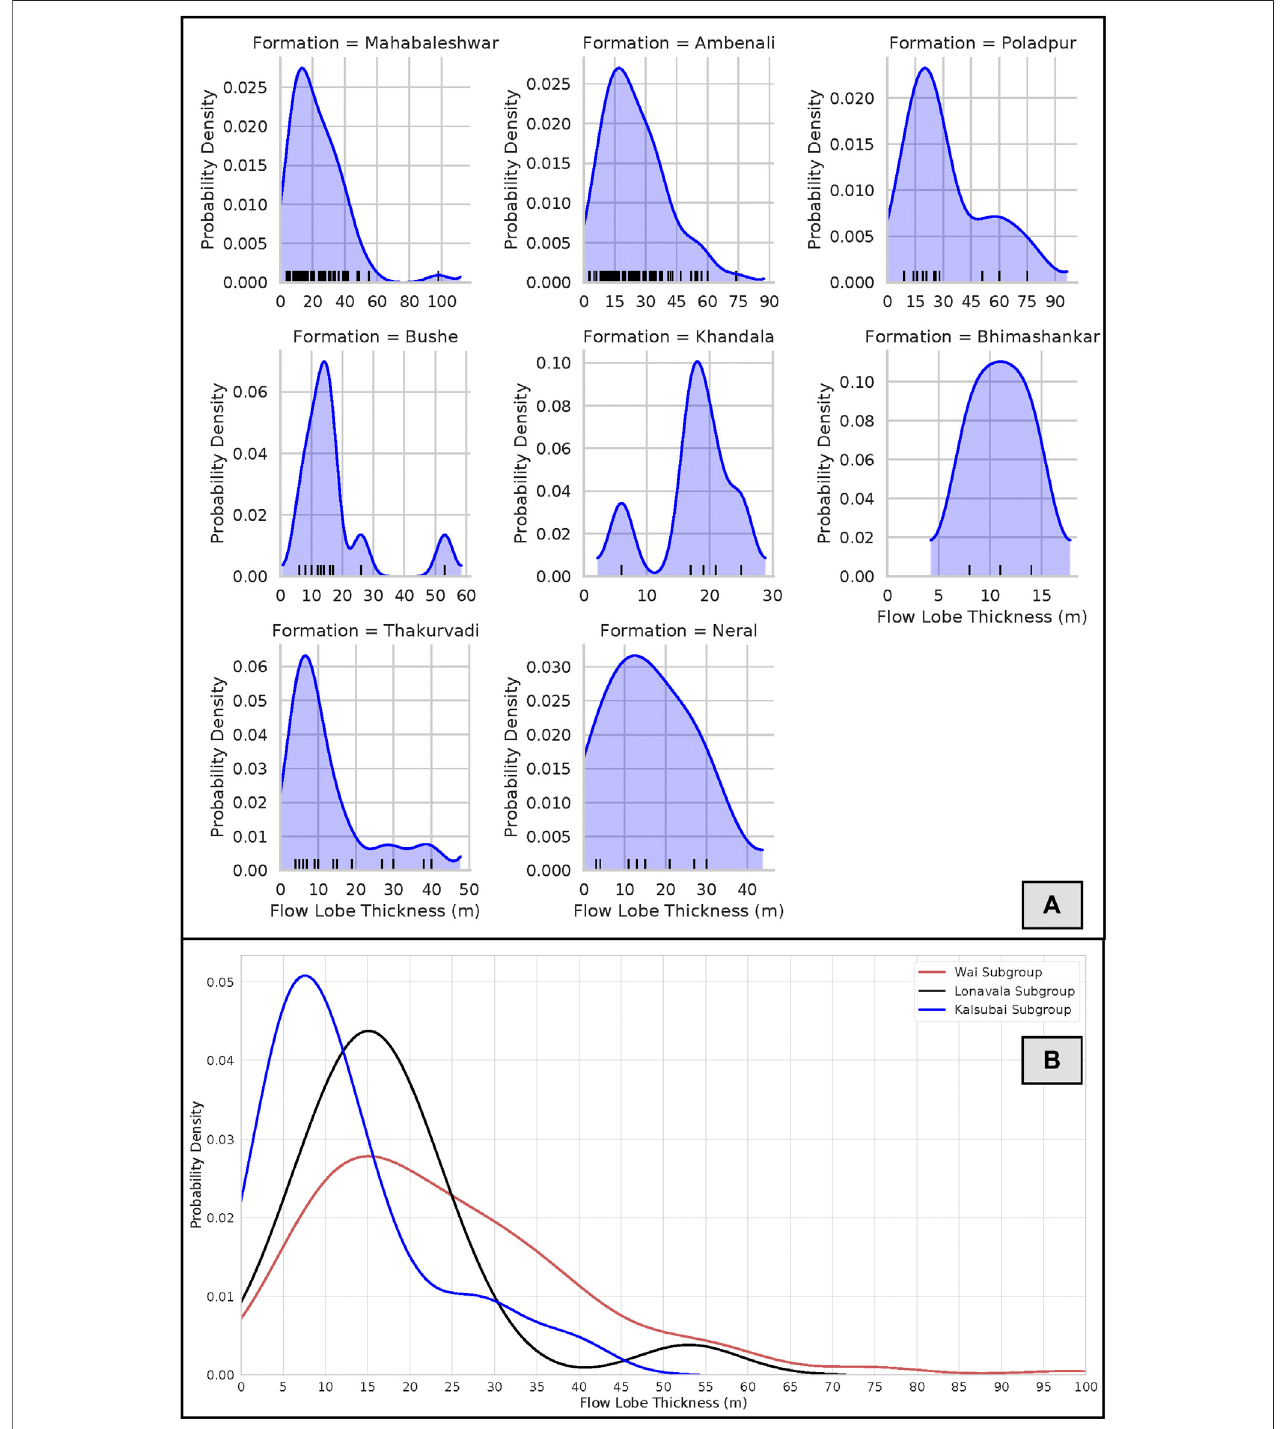
FIGURE5|(A) Plotsofunivariatekerneldensityestimatorstocalculateprobabilitydensityfunction(PDF)oflavalobethicknesses inDeccandataset.Verticalscale is%ofPDF withareaunderPDF curvenormalizingtoone. Result foreach recognized formation isarrangedfrom youngest tooldest (top tobottom) withticksat baseof each plot showing actual value of measured lava lobe thicknesses. (B) Univariate kernel density estimator to calculate probability density function (PDF) of lava lobe thicknesses in accumulated formations within each Deccan subgroup, see Figure 3B ). Plot gives useful view of whole thickness distribution at a glance: middle (Lonavala) subgroup has one modal lobe thickness of ∼ 18 m and another at ∼ 50 m; lowest (Kalsubai) subgroup has smallest modal lobe thickness and coarse tail extendingtoward50 m;upper(Wai)subgrouphassamemedianthicknessasmiddlesubgroupandcoarsetailextendingtoward100 m.Eachsubgrouphassmalllobes and lowest one contains highest